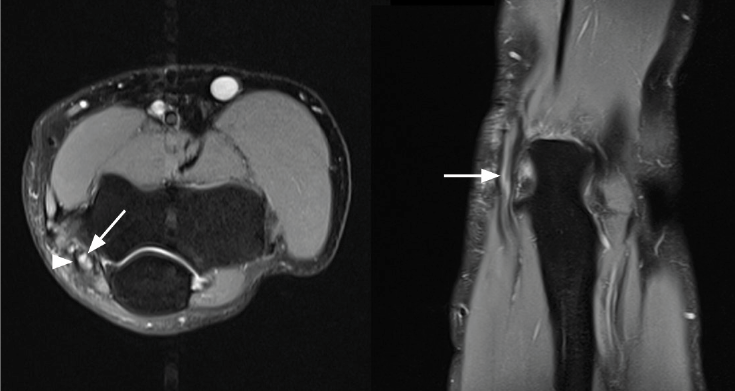
Fig. 1. Axial and coronal fat-suppressed MR images of the left elbow demonstrating increased signal in the thickened ulnar nerve (arrows). Note the normal retinaculum (arrowhead).